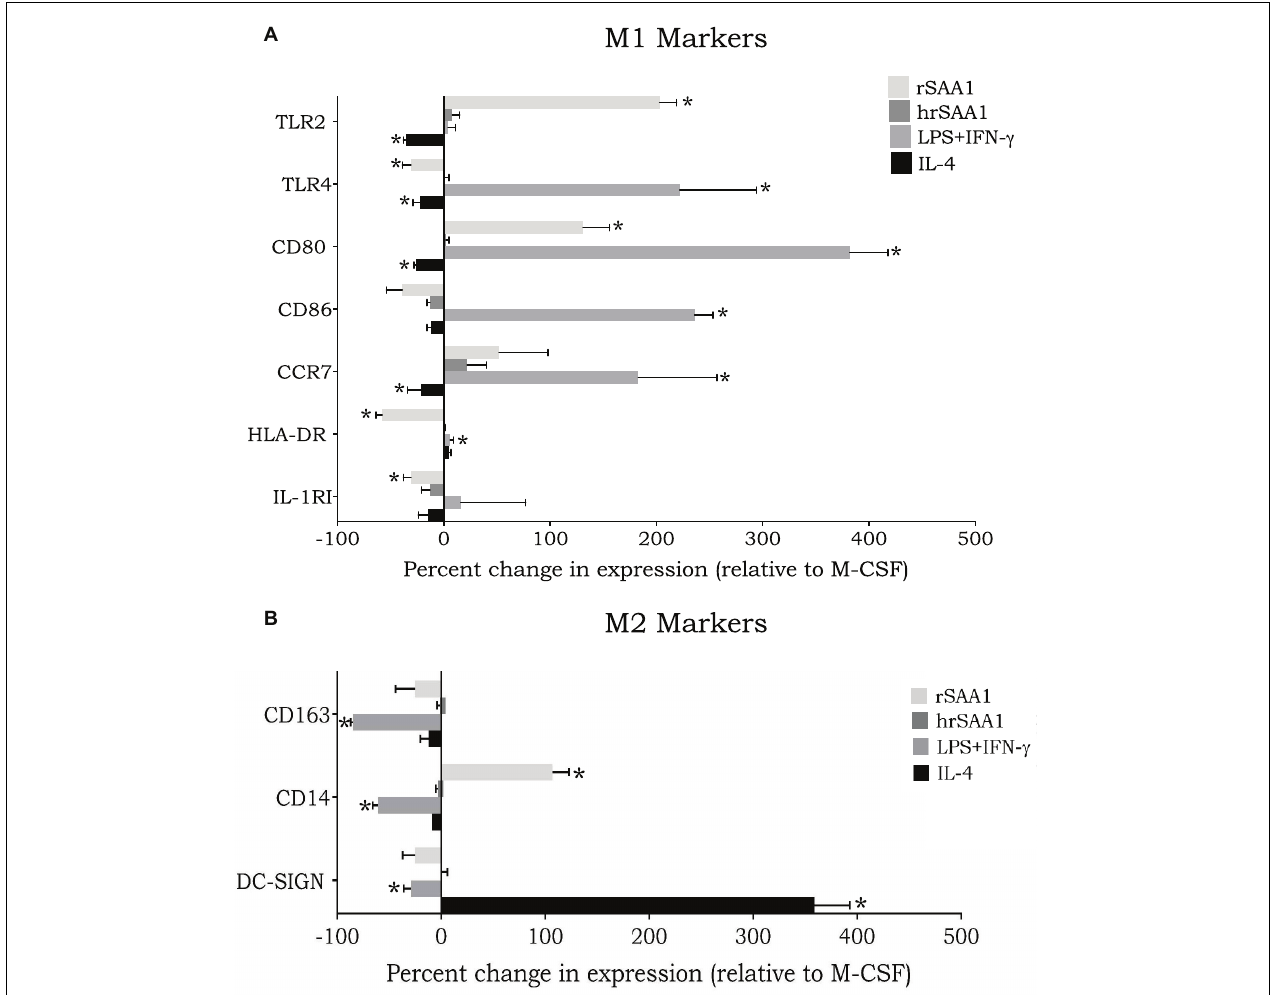
FIGURE 6 | hrSAA1 does not mediate macrophage polarization. Freshly isolated monocytes were treated with M-CSF (100 ng/ml, 2.7 nM) on day 0 to induce macrophage differentiation. On day 4 cells were treated with IFN- γ (25 ng/ml, 1.5 nM) plus LPS (100 ng/ml), IL-4 (20 ng/ml, 1.3 nM), rSAA1 (100 ng/ml, 8 nM), or homogenous rSAA1 (hrSAA1) (100 ng/ml, 8 nM) to promote macrophage polarization. On day 6 of culture, macrophages were collected and analyzed for expression of (A) M1 markers and (B) M2 markers using flow cytometry. Results are presented as the mean percent change in expression compared to M-CSF-treated cells + SEM (i.e., 0% is equivalent to the same expression level as M-CSF-treated cells) and are derived from seven independent experiments. Significant upregulation in comparison to control is indicated by asterisks (Wilcoxon signed-rank test; * p -value <